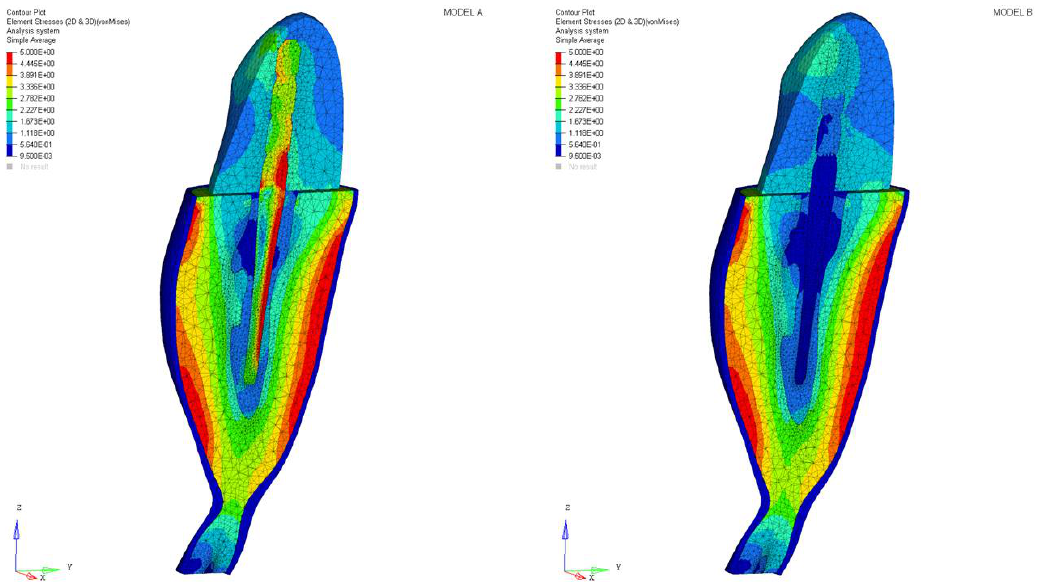
Figure 3. von Mises stress distribution (MPa): model A and model B.